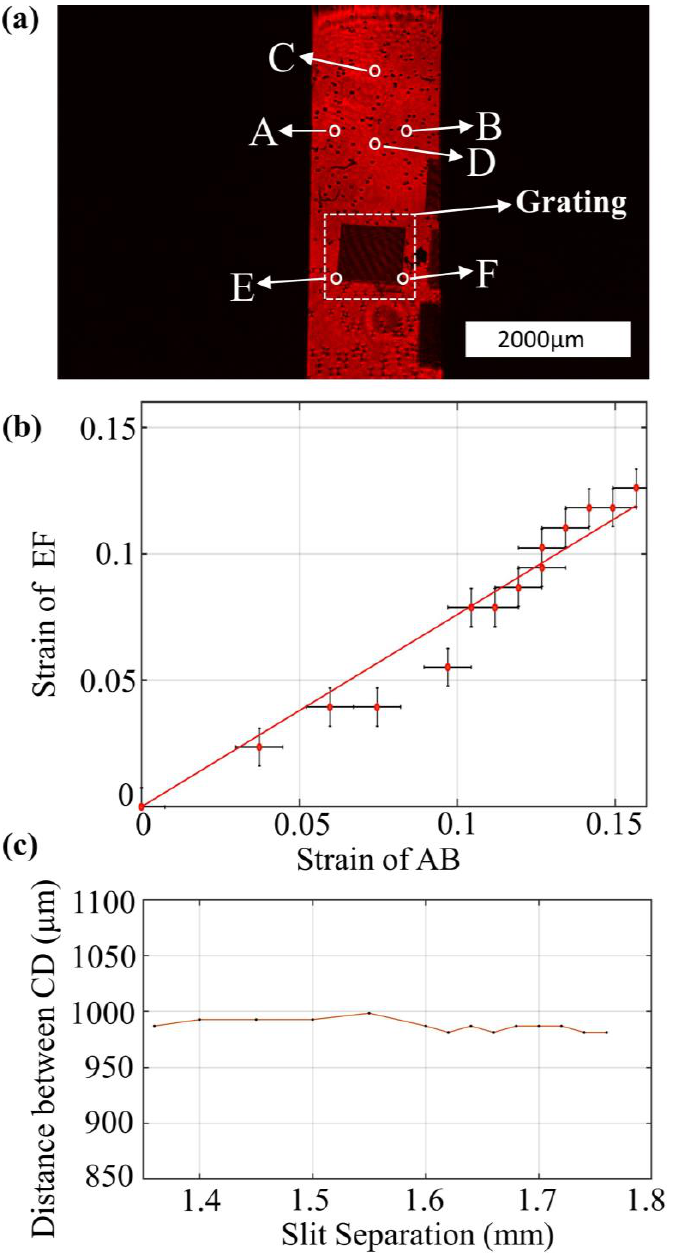
Figure 8. Comparison of the stiffness of the polymer network in either the laser written or UV polymerized regions in the stretchable films. ( a ) Photograph of the stretchable film when illuminated with a 635 nm laser diode and captured with the CCD camera. The six spacer beads are labelled A- F. By tracking the separation between A & B and E & F as the film is stretched, the relationship between the strain for the region occupied by the (laser written) grating and that of the surrounding (UV polymerized) film can be determined. ( b ) The strain for the region between E and F as a function of the strain experienced for the region between A and B. The red line represents a line of best fit. ( c ) Separation between spacer beads C and D as a function of the slit separation. The red line is to guide the eye.